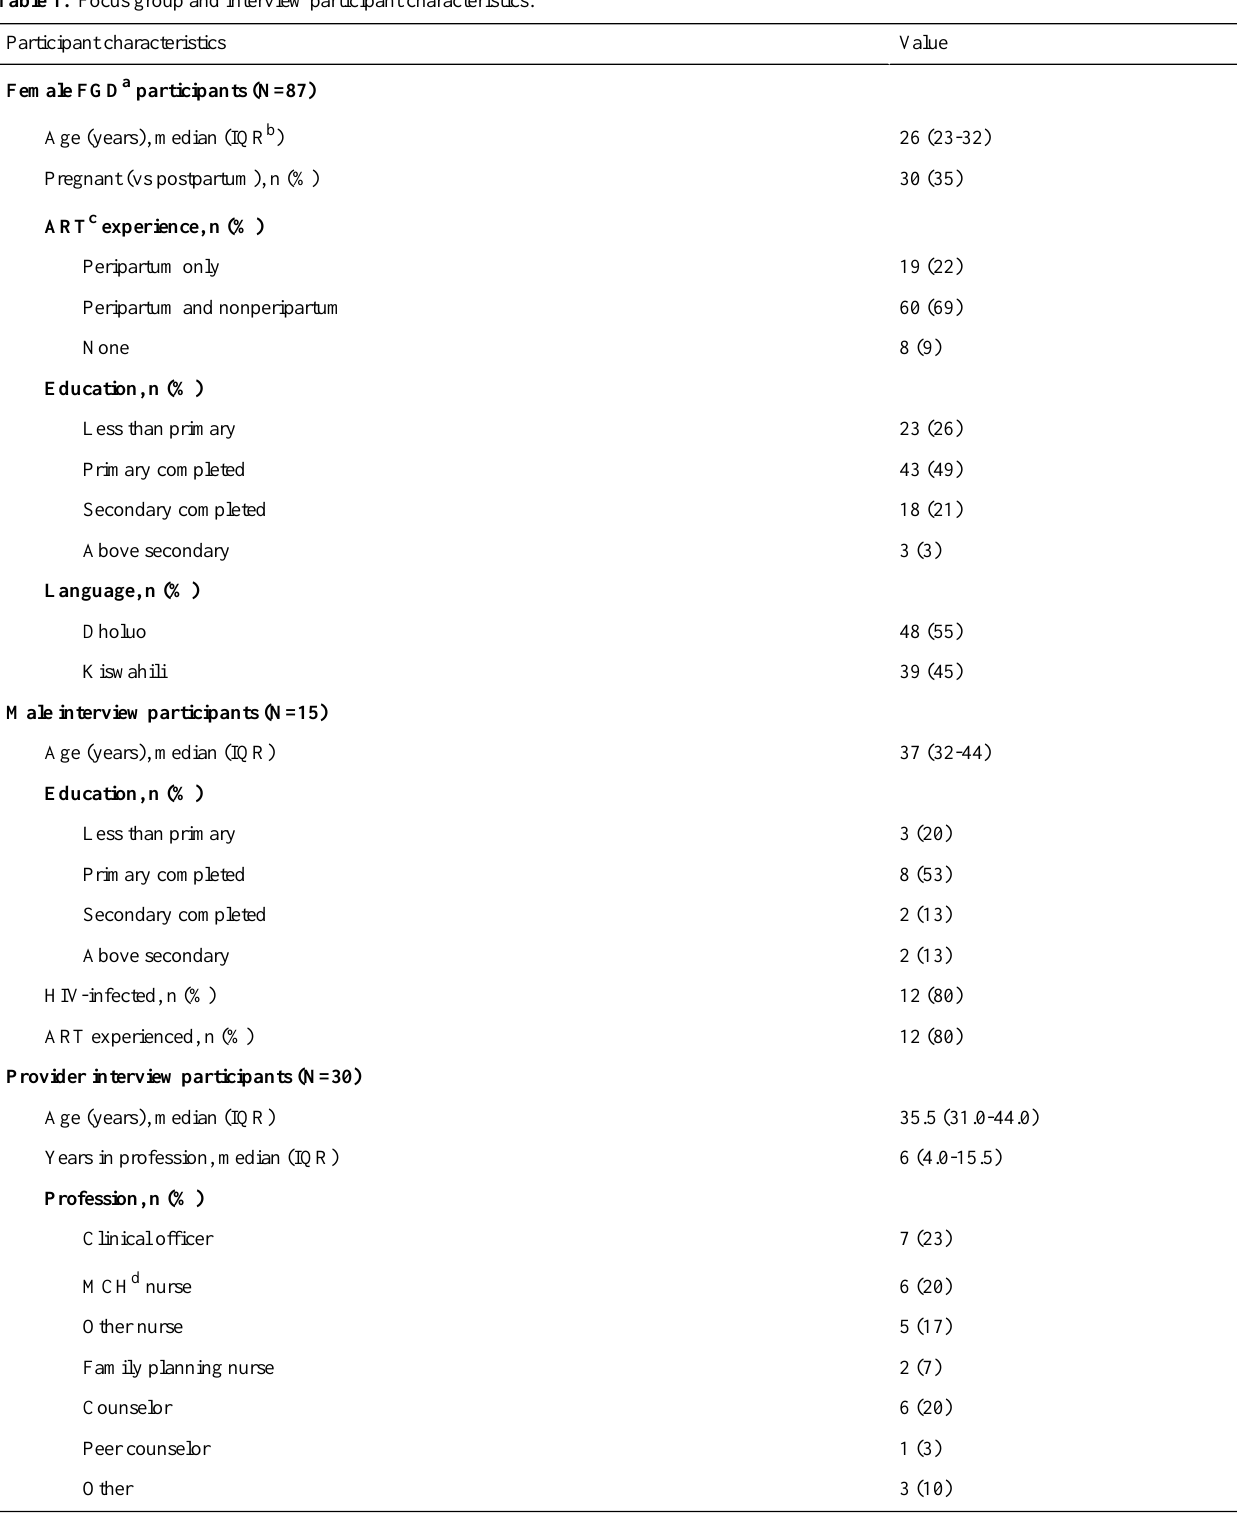
Table 1. Focus group and interview participant